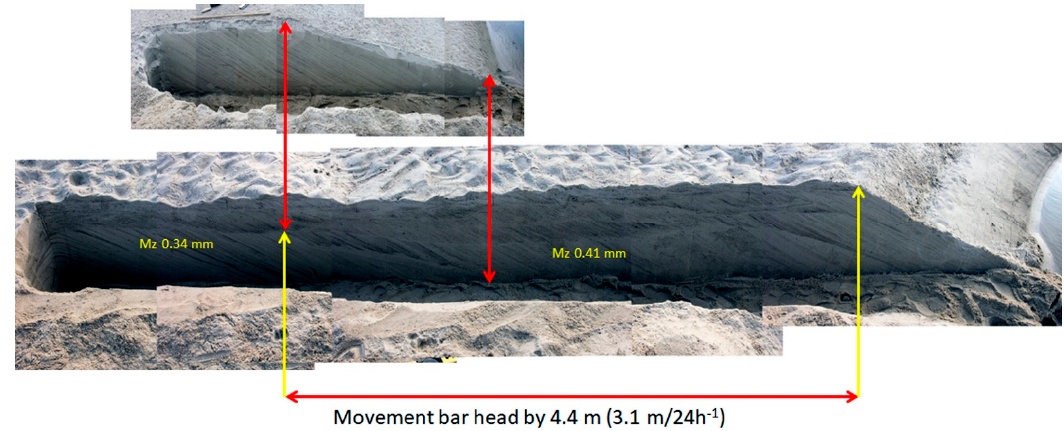
Figure 12. The record of bar head movement in sedimentary structures of the channel bar—20 November 2012.